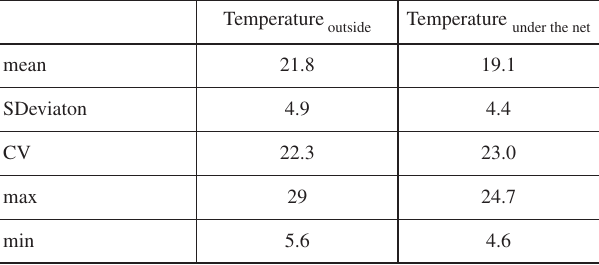
Table 1. The statistical parameters of daily amplitude of temperature changes measured under the hail protection net and outside of it /Pallag 2011 June 1 – September 30/